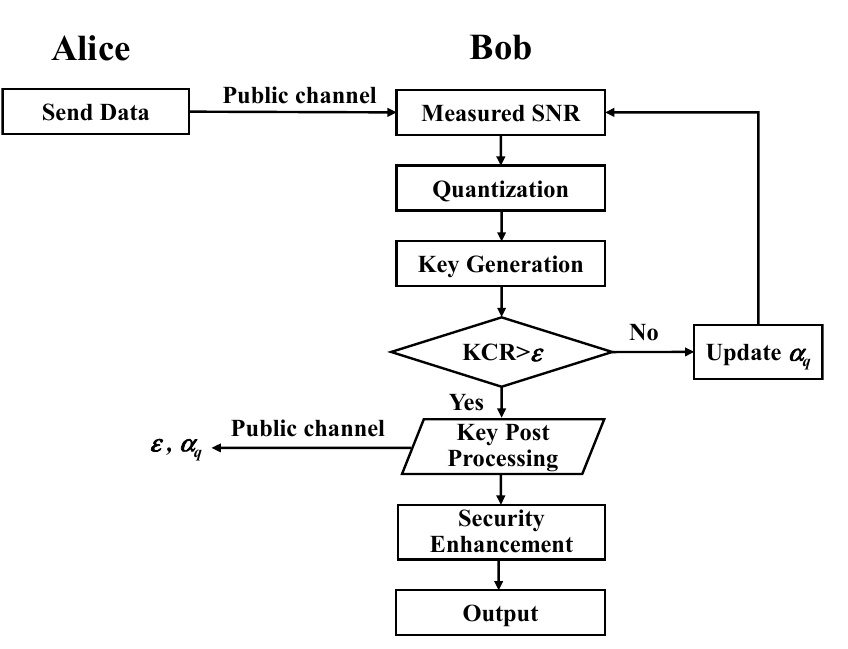
Figure 3. Optimized key generation factors ε and α q.